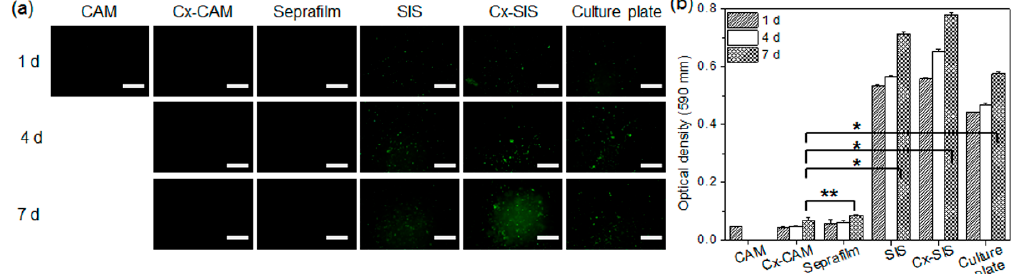
Figure 5. ( a ) PKH67 green fluorescence images and ( b ) MTT assays of HUVECs cultured on CAM, Cx-CAM, SIS, Cx-SIS, Seprafilm, or a culture plate for 1, 4, or 7 days (magnification is 200 × , and the scale bar represents 100 μ m; * p < 0.001, ** p > 0.99).